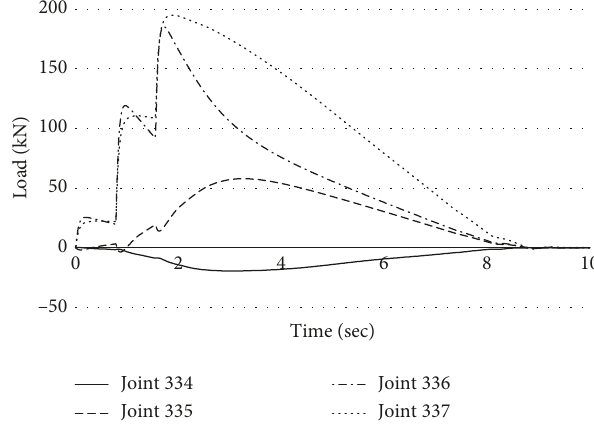
Figure 9: Loads measured by BWIM bearings at the entrance side (speed � 20km/h).